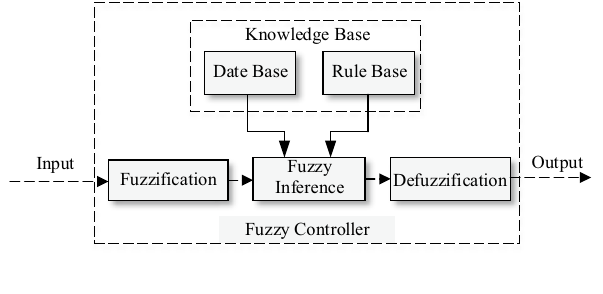
Fig. 5 Structure diagram of fuzzy controller